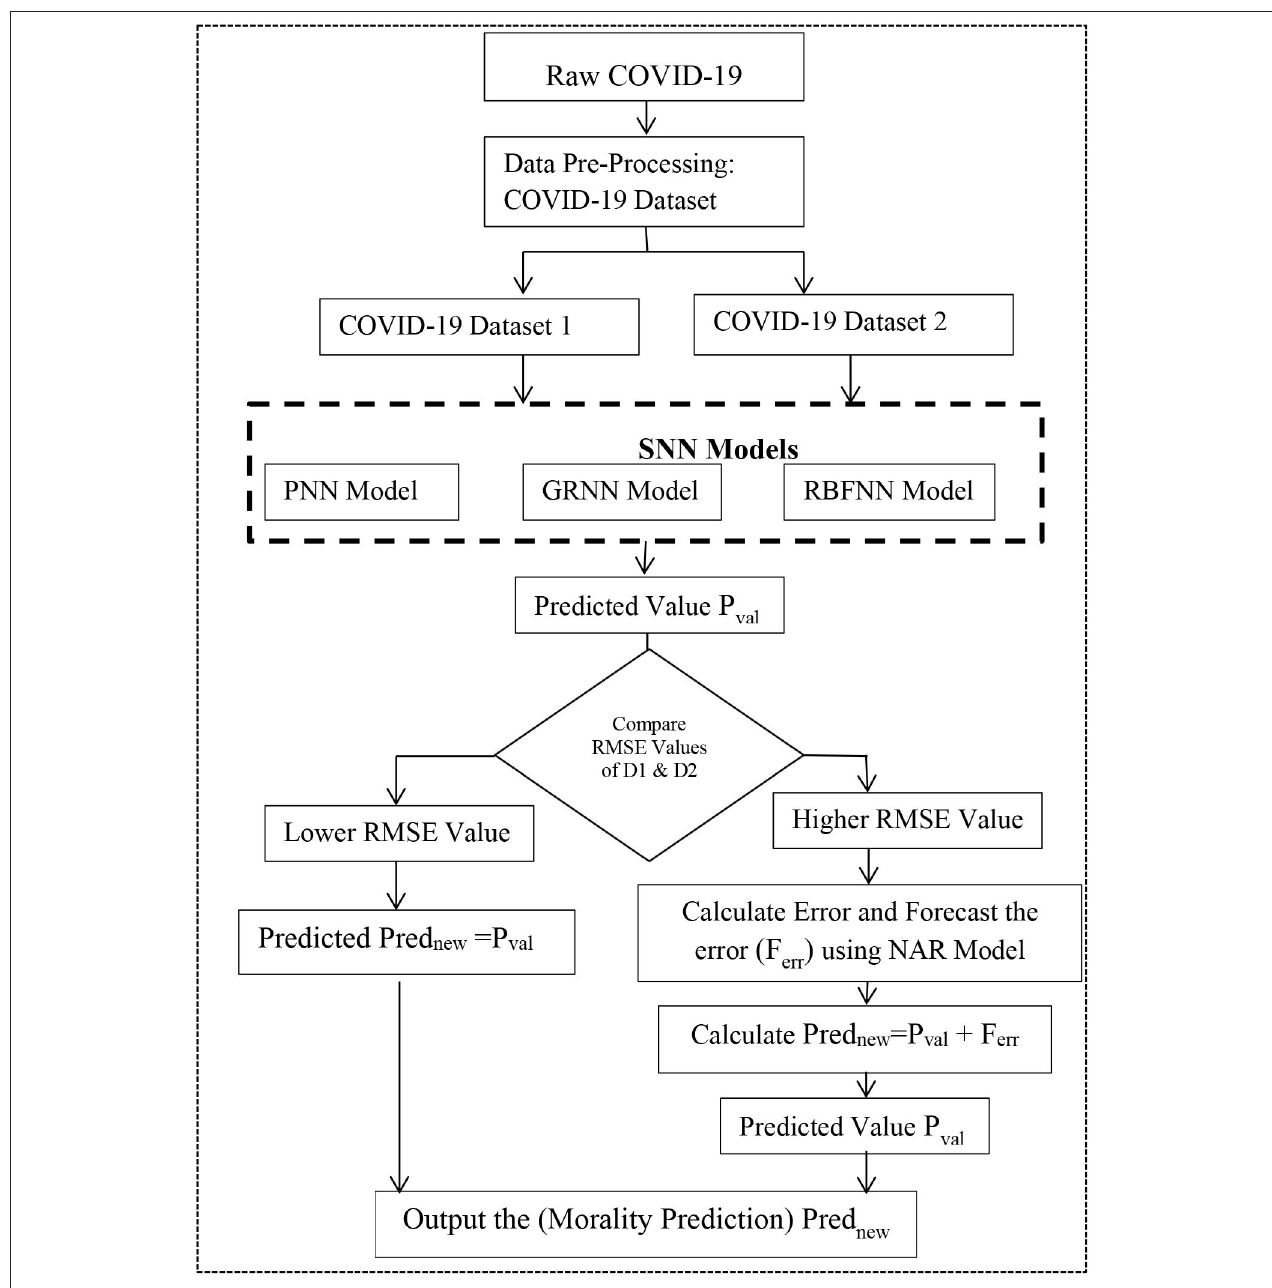
FIGURE 1 | Proposed methodology for COVID-19 MRP